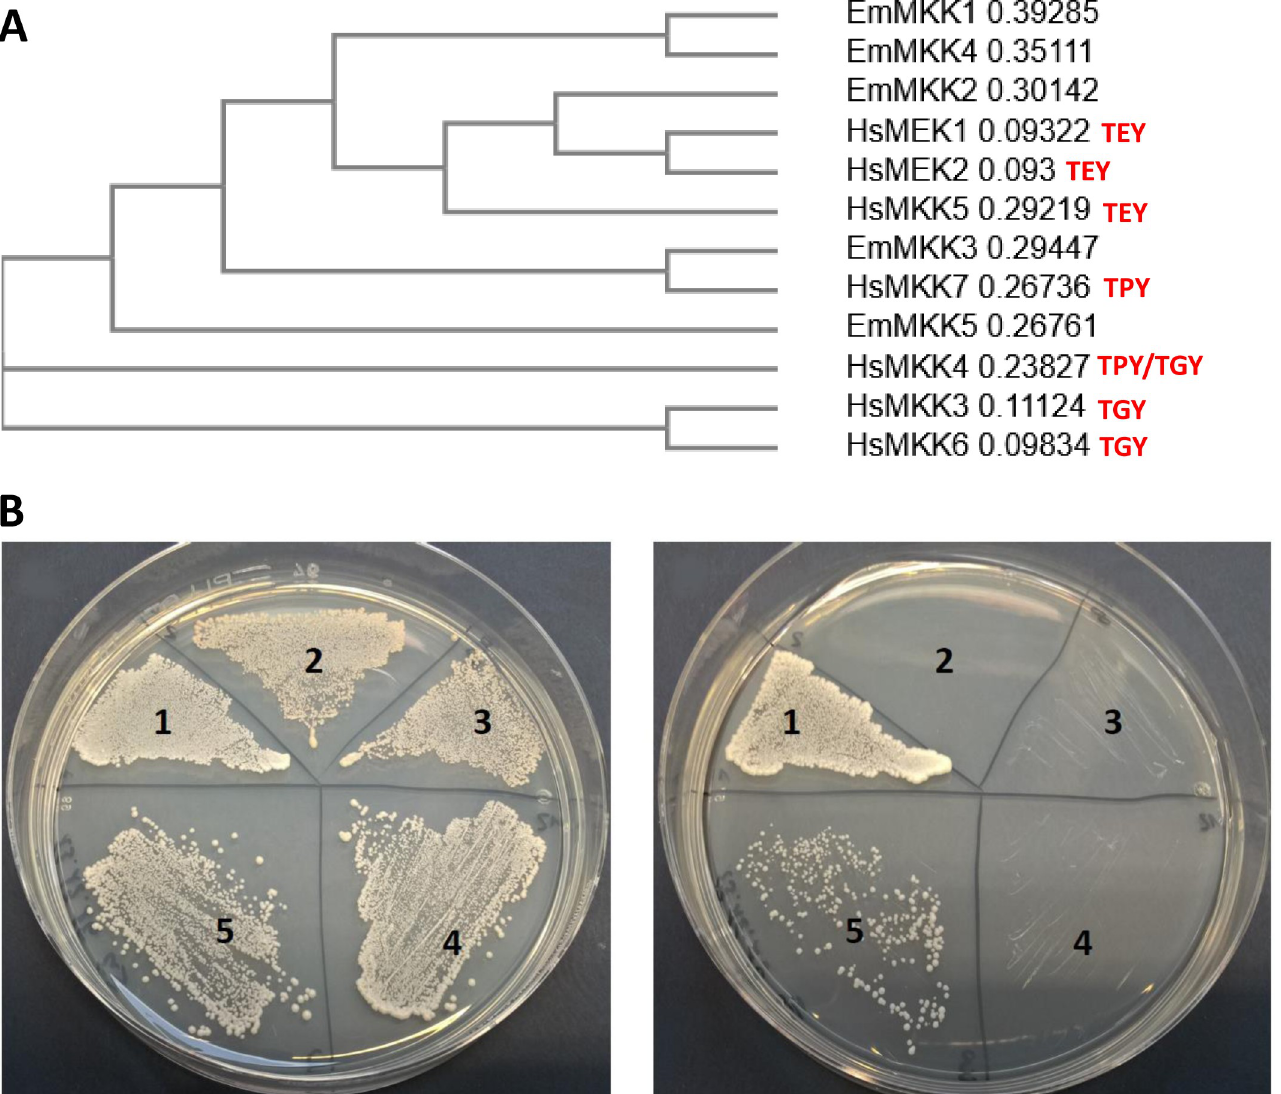
Fig 4. Interaction between EmMEKK1 and EmMKK3. A) Phylogenetic tree of Echinococcus MAPKK (as characterized in this work) and human MAPKK. CLUSTALW alignment was performed with full-length amino acid sequences of E . multilocularis EmMKK1 (accession no. FN434110), EmMKK2 (FN434111), EmMKK3 (MW358635), EmMKK4 (MW358636), and EmMKK5 (MW358637) as well as human (Hs) MKK1 (Q02750), MKK2 (P36507), MKK3 (P46734), MKK4 (P45985), MKK5 (Q13163), MKK6 (P52564), and MKK7 (O14733). Node distances are indicated to the right. Specificities of human enzymes to MAPK of the Erk-branch (TEY), the JNK-branch (TPY) and the p38-branch (TGY) are indicated in red. B) Y2H experiment showing the interaction between EmMEKK1 and EmMKK3. Left plate, SD-Leu-Trp for transfection control; right plate, SD-Leu-Trp-His with 7,5 mM 3-Amino-1,2,4-triazol. 1, positive control (T-antigen- AD x p53-BD); 2, negative control (T-antigen-AD x lamC-BD); 3, EmMEKK1-5‘-AD x empty-BD; 4, EmMKK3-BD x empty-AD; 5, EmMEKK1-5‘-AD x EmMKK3-BD.